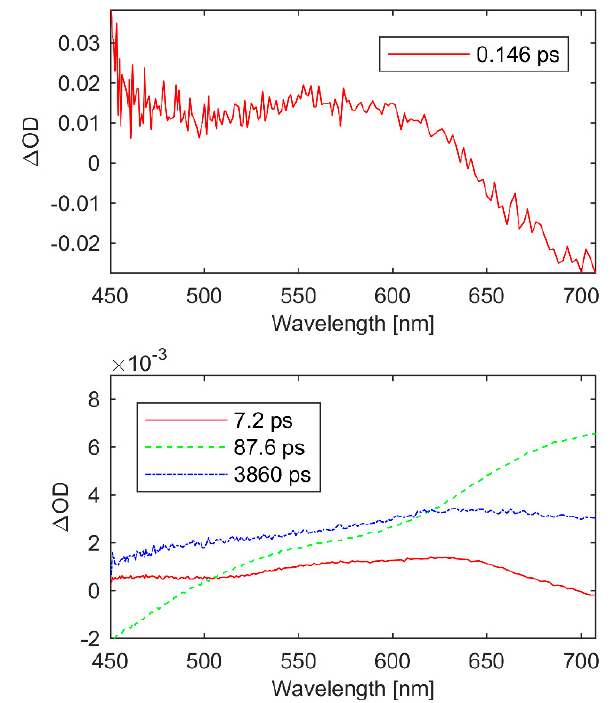
Figure 7. Spectral basis vectors for molecule “B”. See Equation (1) for explanation. While the optimizer converged for the 0.15 ps and 3.9 ns decay, too few data points were available to give a trustworthy fit. For molecule “C”, the basis vectors are presented in Figure 8. Decays with time constants of 0.2 ps, 2.6 ps, 70.7 ps, and 710 ps were obtained. The quality of the subpicosecond decay fit was, as with molecule “B”, of limited quality. Furthermore, while the 2.6 ps decay was characterized by a